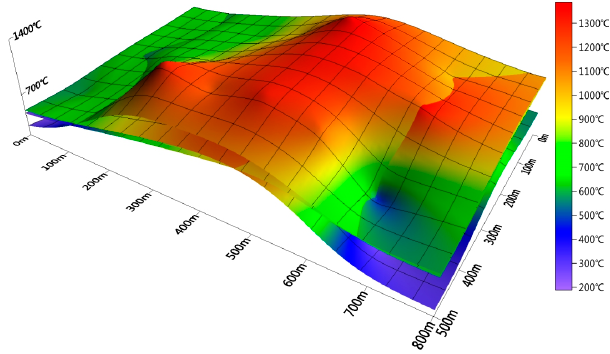
Figure 7. Temperature profile distribution during UCG simulation test (80%-O 2 ).